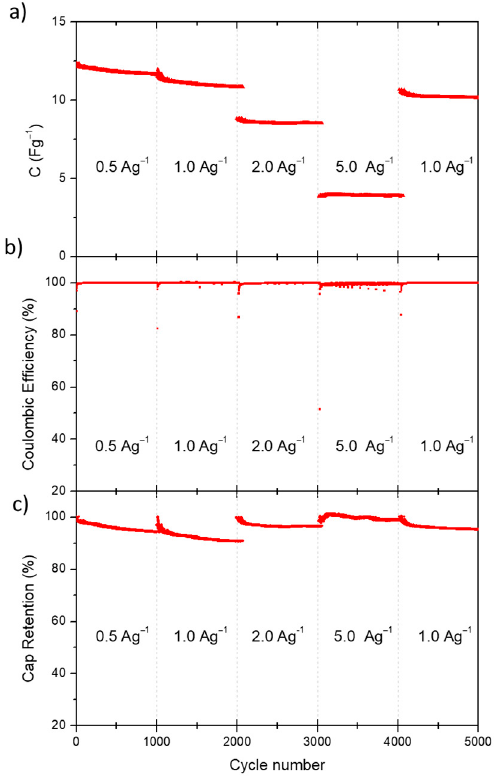
Figure 5. ( a ) Evolution of specific capacitance, ( b ) coulombic efficiency and ( c ) capacitance retention of EDLCs containing LA-H,H/TEMABF 4 at different current densities.